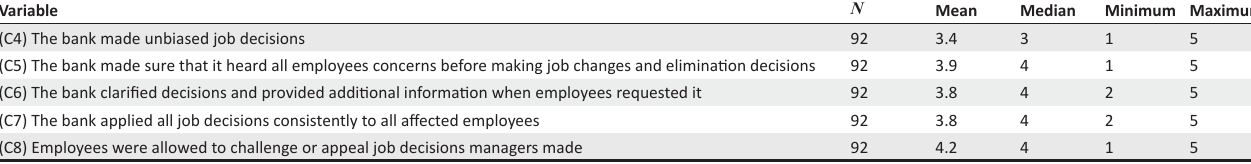
TABLE 3: Descriptive statistics for survivors’ perceptions of the bank’s decision-making methods (section C). Variable